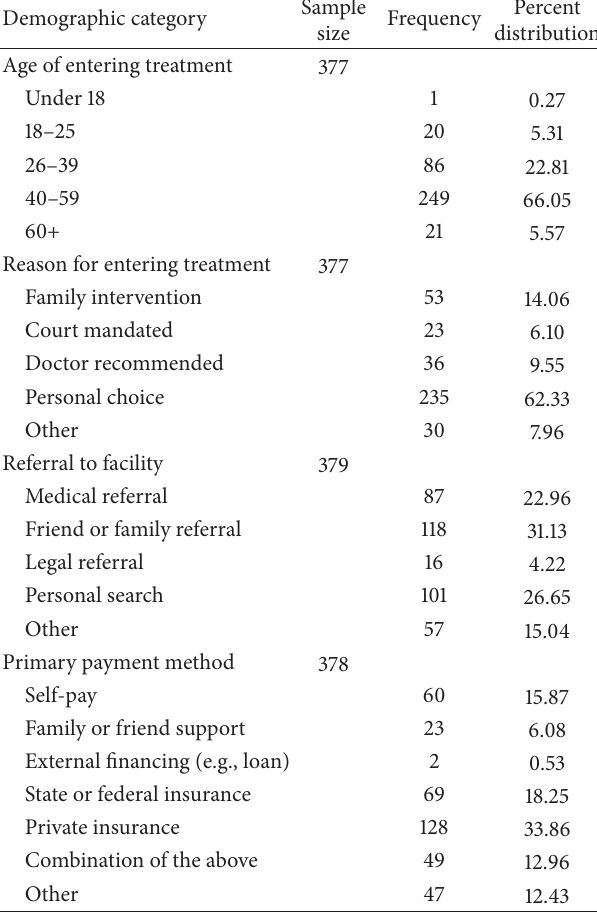
Table 1: Population profile of 379 survey